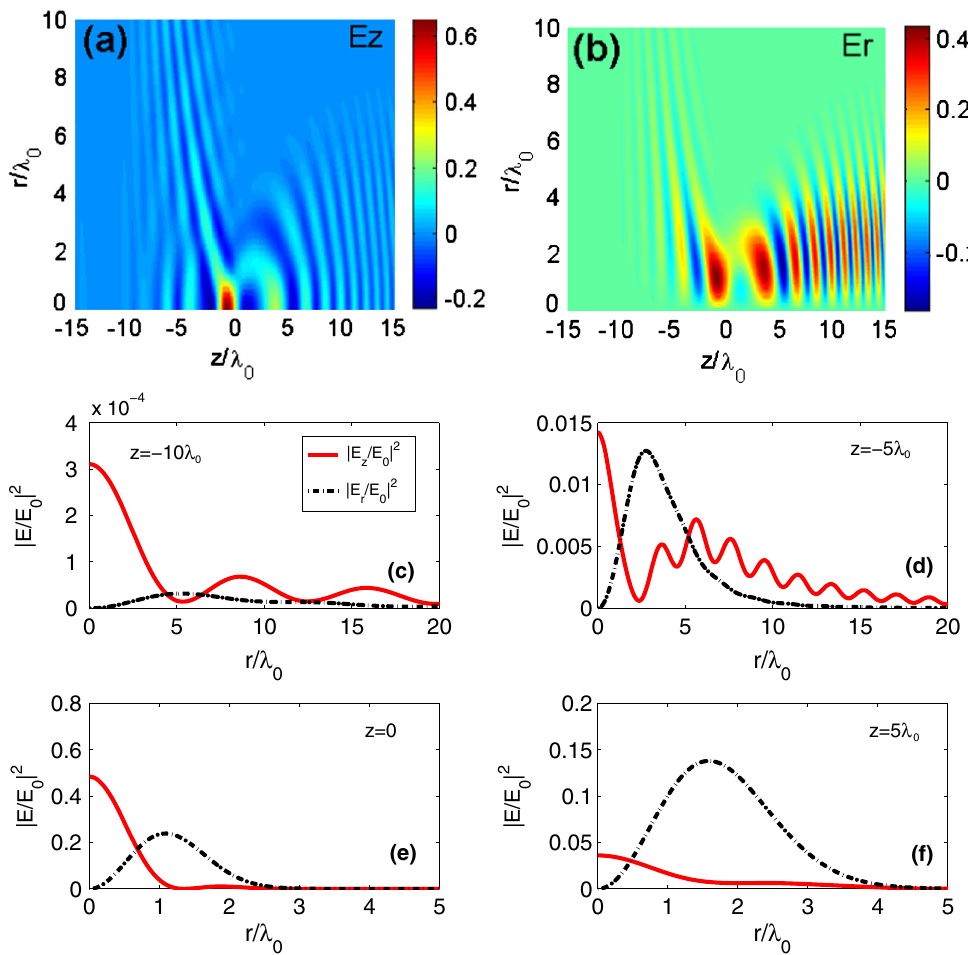
=E (a) and the axial field E r 0 j 2 and j E j 2 on different z planes at z ¼ (cid:1) 10 (cid:7) =E =E r z 0 0